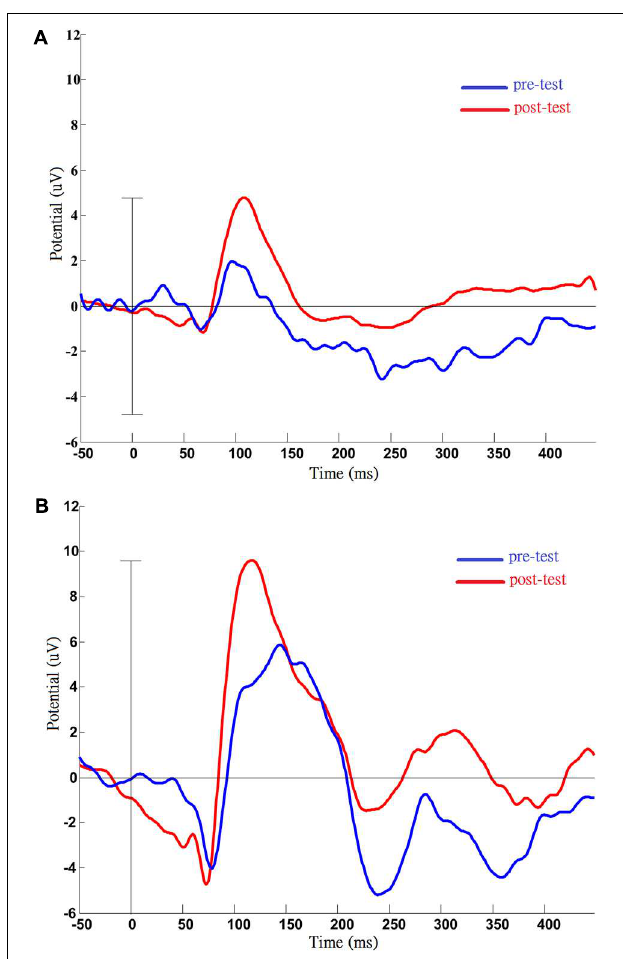
FIGURE 2 | Results of pattern visual evoked potential (VEP) testing before and after the VS program in case A5 (A) and case A6 (B). Pre- and post-measurements of VEP were completed by case A5 and case A6. After training, the VEP amplitude was increased compared with pre-test, and this phenomenon was persistent in two cases. (A) Data from case A5: increased P100 amplitude (pre: 1.97 uV; post: 4.78 uV); (B) Data from case A6: post-training, shortened latency (pre: 144 ms; post: 118 ms), and increased amplitude of P100 (pre: 5.85 uV; post: 9.59